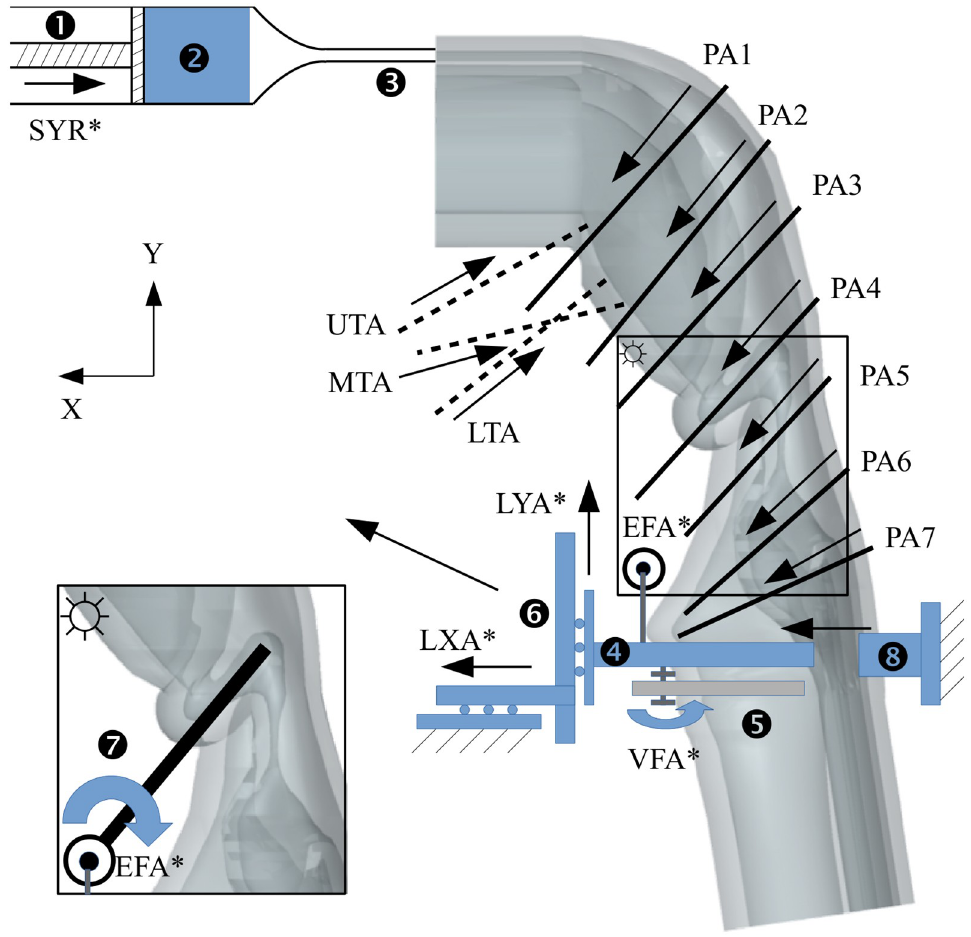
Fig 5. List of actuator (linear and rotational) connections and corresponding labels. (1) syringe piston; (2) bolus material; (3) injection nozzle; (4) ‘cricoid’ piece; (5) vocal fold pinching clamp; (6) horizontal and vertical slides; (7) epiglottic metal stem; (8) upper esophagus connection to aluminum frame. Solid black lines represent the pharynx actuation wires while dotted lines represent the tongue actuation wires. � stands for non curved actuation wires. The whole actuation system of the epiglottis (e.g. shaft and transmission belts) is not represented.